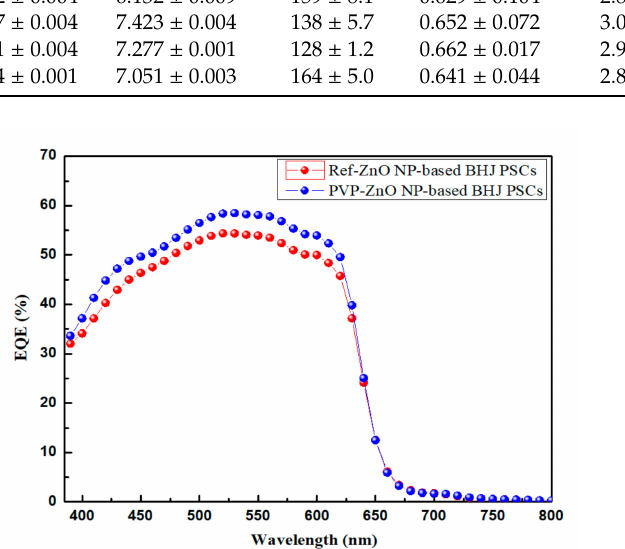
Figure 6. External quantum e ffi ciency characteristics of ( Red ) Ref-ZnO NP-based BHJ PSCs and ( Blue ) PVP-ZnO NP-based BHJ PSCs.